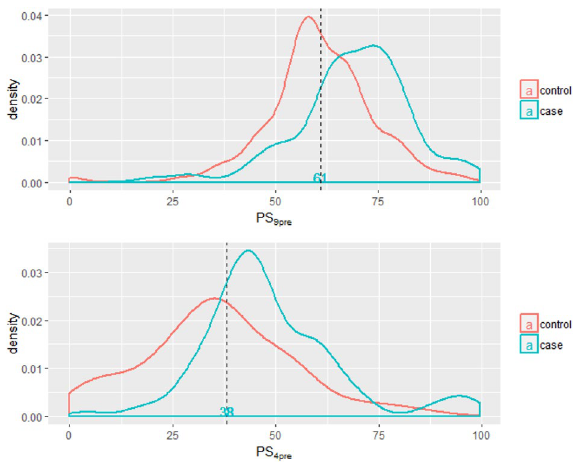
Figure 2. The distribution curve of PS 9post and PS 4post among controls and cases of postmenopausal women (the dashed line was the cut-off value based on ROC). The curve was conducted using R 3.5.1 software (R Core Team, Vienna, Austria, 2018. https:// www.R- proje ct. org/) and Microsoft EXCEL software (Microsoft, USA, 2016. https:// www. micro soft. com/ zh- cn/ micro soft- 365/ excel).